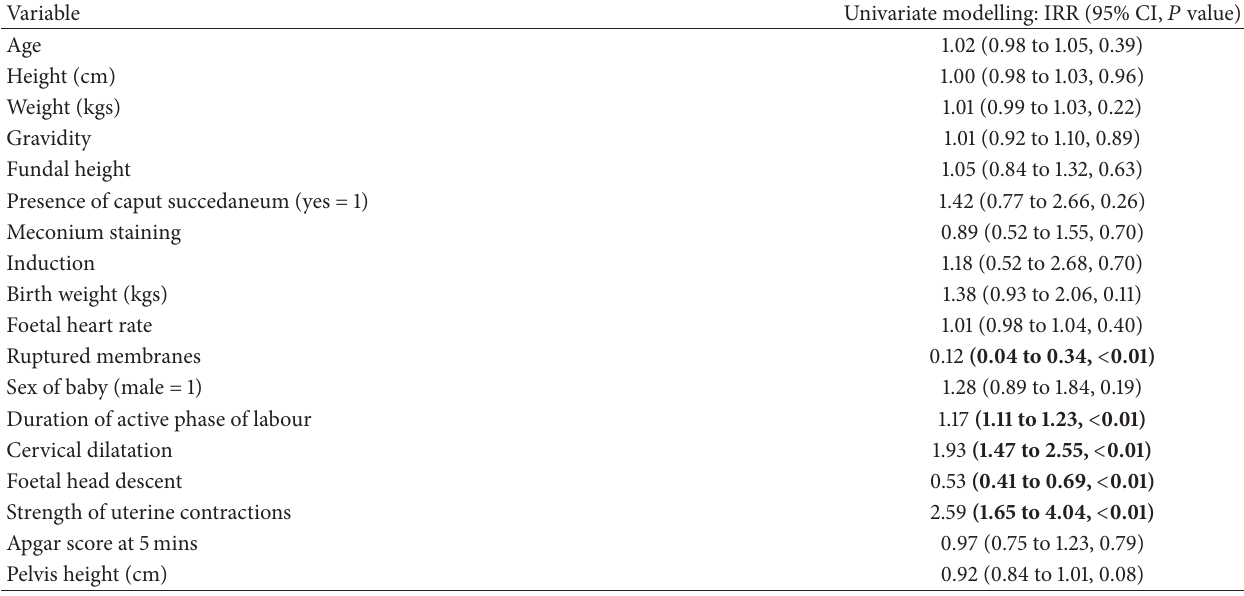
Table 3: Showing univariate regression modelling of foetal head moulding by the study variables.